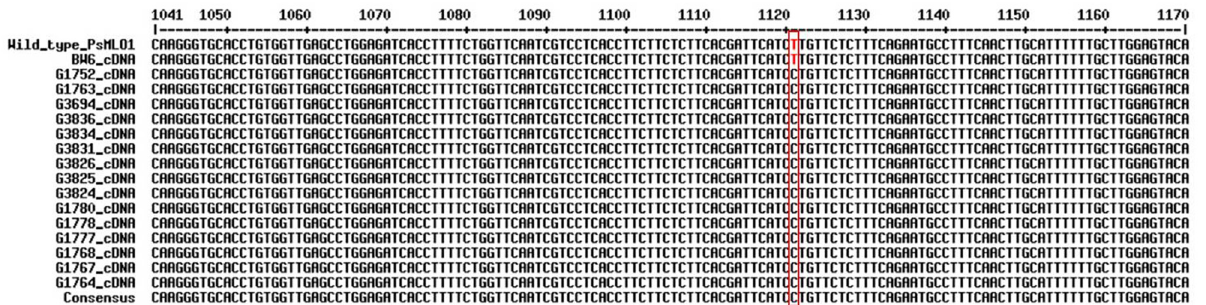
Fig 1. Comparisons of the cDNA sequence of the PsMLO1 gene from the wild-type pea cultivar Sprinter (Wild_type_PsMLO1) and Bawan 6 (BW6_PsMLO1_cDNA), which are susceptible to E . pisi , and the 16 resistant pea landraces. Mutated sites in the PsMLO1 cDNA sequence are boxed in